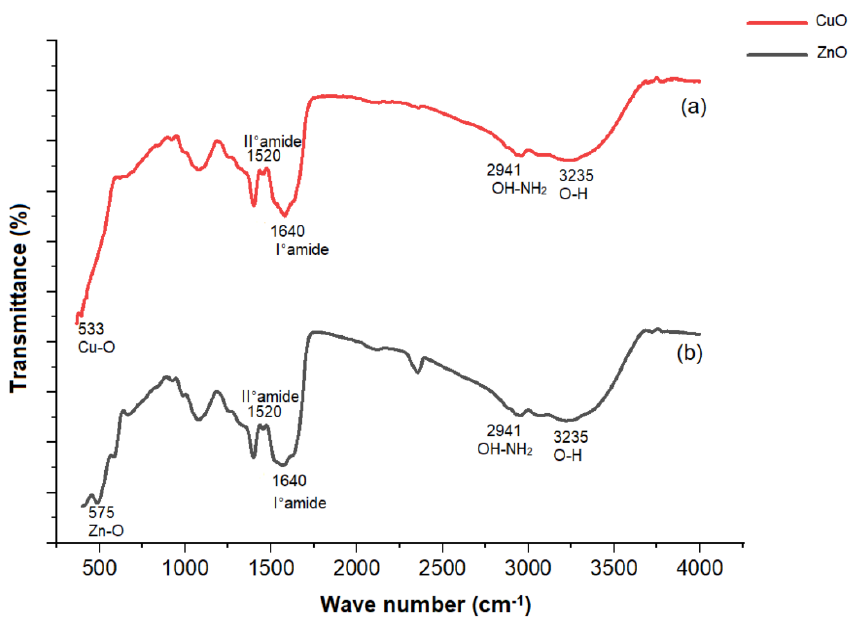
Figure 4. FTIR spectra of ( a ) bacteriogenic CuO nanoparticles and ( b ) bacteriogenic ZnO nanoparticles synthesized by Stenotrophomonas maltophilia. Table 1. Determination of the crystallite size of biosynthesized CuO and ZnO nanoparticle synthe- sized using XRD